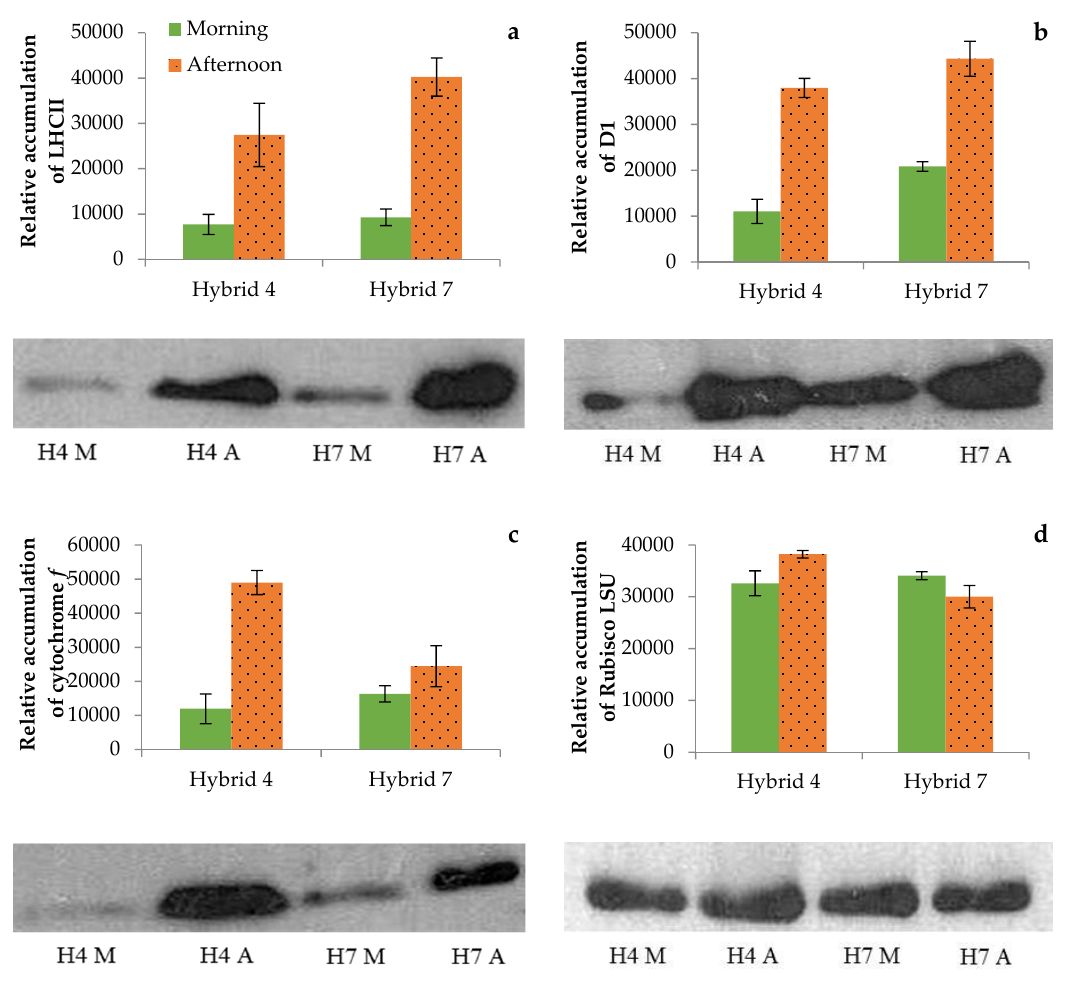
Figure 3. The relative accumulation of photosynthetic proteins: ( a ) light-harvesting complex of photosystem II—(LHCII); ( b ) D1; ( c ) cytochrome f (cyt f ); and ( d ) Rubisco large subunit—(Rubisco LSU) in sunflower hybrids 4 and 7 (H4 and H7) under the morning (M) and afternoon (A) conditions. Lines in graphs represent mean values ± standard deviations of three replicates ( n =